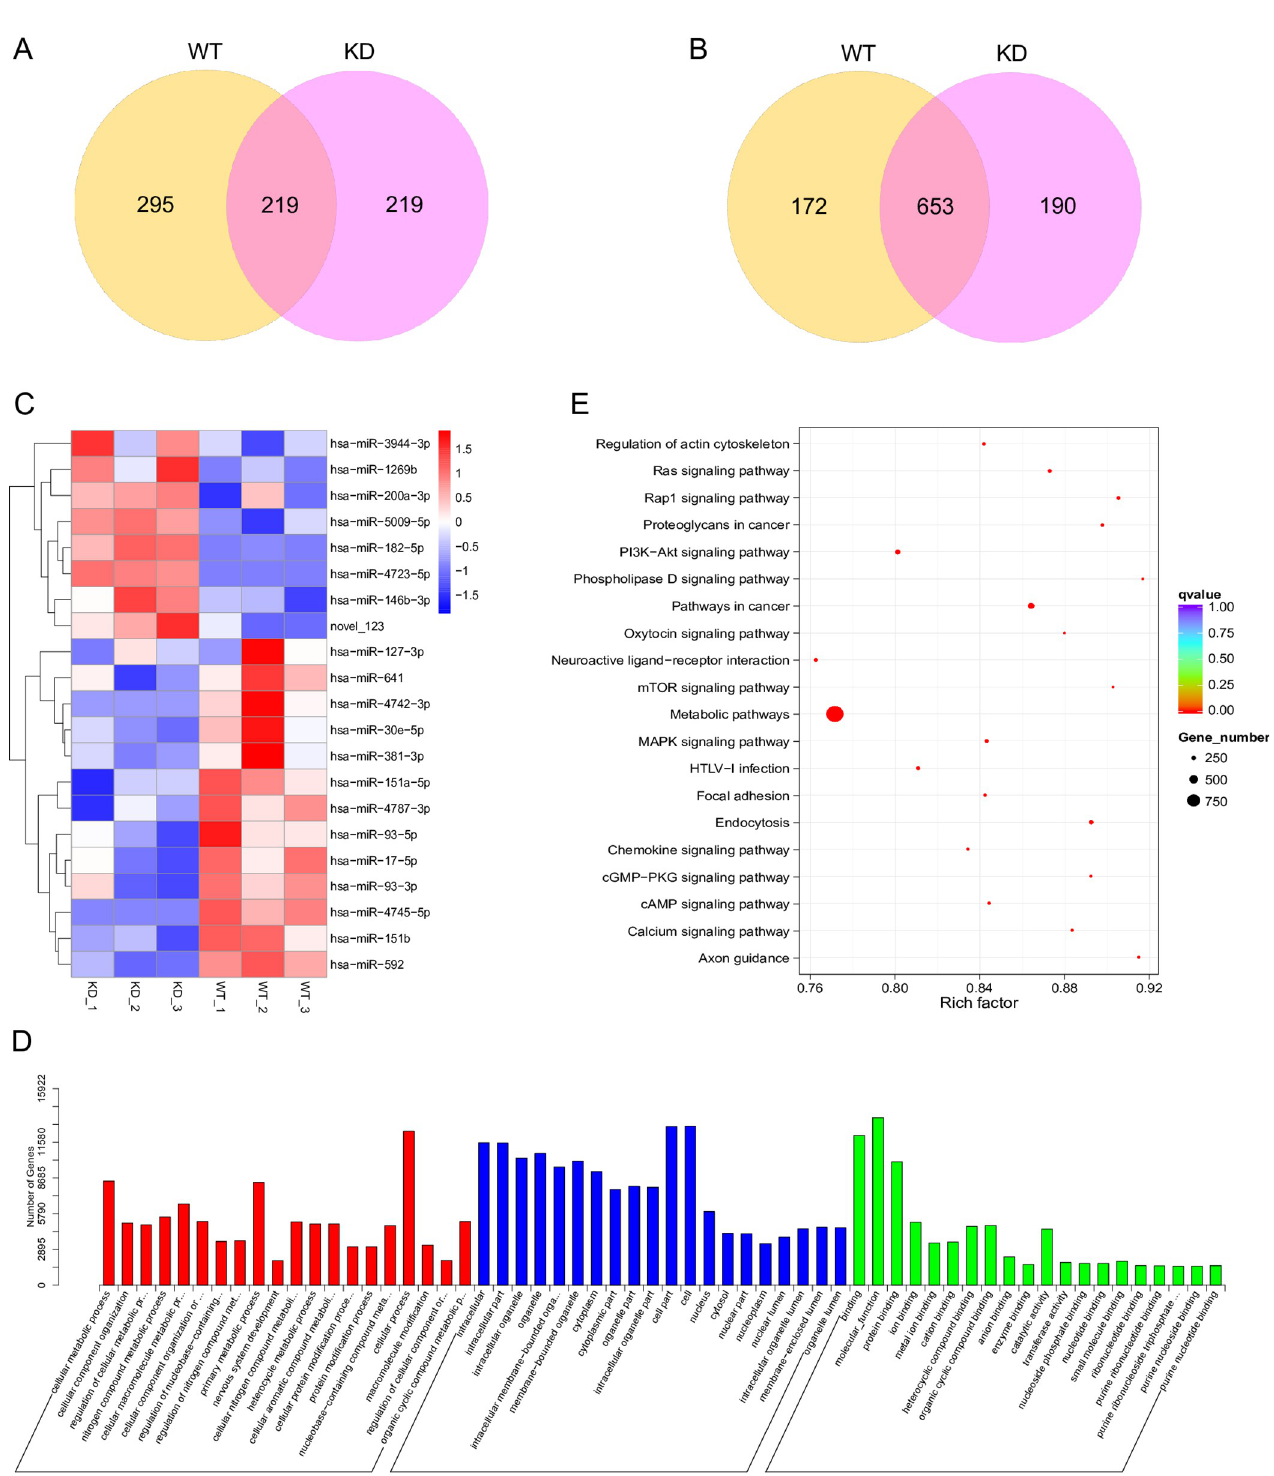
Fig 3. MicroRNA differential expression and pathway enrichment of predicted MicroRNA targets. (A) Venn diagram of the number of unique microRNAs determined to be expressed in either WT PUM background (purple) or KD PUM background (yellow), or co-expressed in both treatments (pink; overlap) based on raw sequence reads. (B) Venn diagram defining the number of microRNAs in WT PUM only (purple), PUM KD only (yellow), or both treatments (pink; overlap) that were determined to be suitable for differential expression analysis. (C) Heatmap of DEMs hierarchically clustered. Changes in log2(ratio) expression are represented as a color change from red to blue or vice versa. (D) Enrichment of GO terms among the predicted targets of DEMs. (E) Analysis of